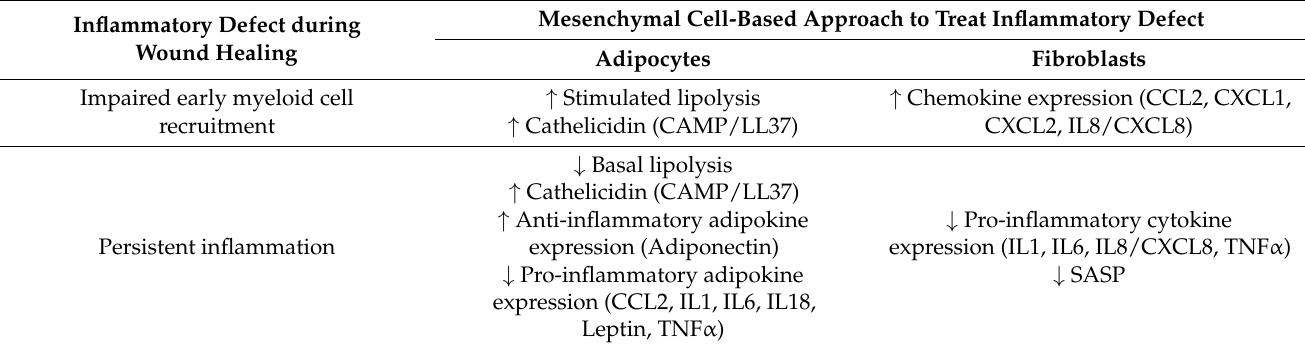
Table 1. Adipocyte- and fibroblast-based therapeutic targets to improve wound healing. Mesenchymal Cell-Based Approach to Treat Inflammatory Defect Inflammatory Defect during Wound Healing Adipocytes Fibroblasts ↑ Stimulated lipolysis ↑ Chemokine expression (CCL2, CXCL1, Impaired early myeloid cell ↑ Cathelicidin (CAMP/LL37) recruitment CXCL2, IL8/CXCL8) ↓ Basal lipolysis ↑ Cathelicidin (CAMP/LL37) ↑ Anti-inflammatory adipokine ↓ Pro-inflammatory cytokine Persistent inflammation expression (Adiponectin) expression (IL1, IL6, IL8/CXCL8, TNF α ) ↓ Pro-inflammatory adipokine ↓ expression (CCL2, IL1, IL6, IL18, Leptin, TNF α )